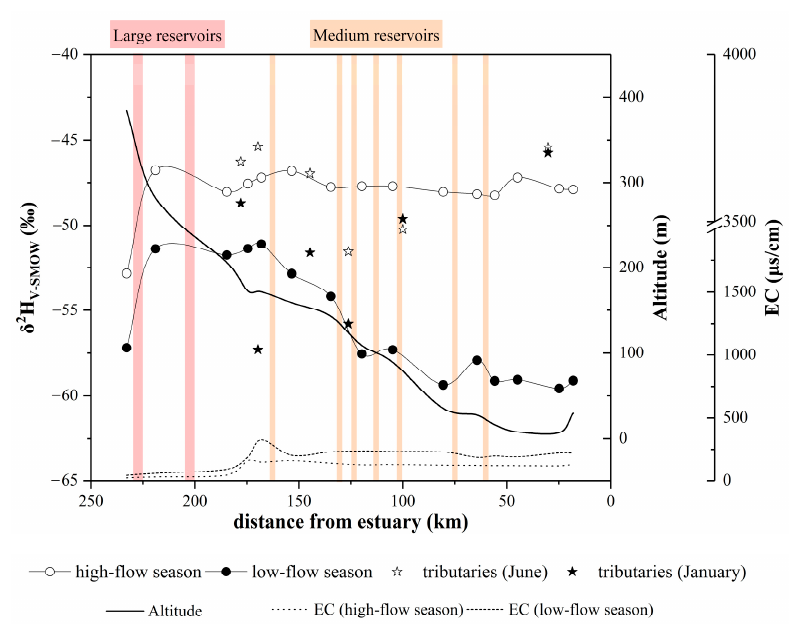
Figure 7. Hydrogen isotope composition and distribution of cascade reservoirs in the North River .